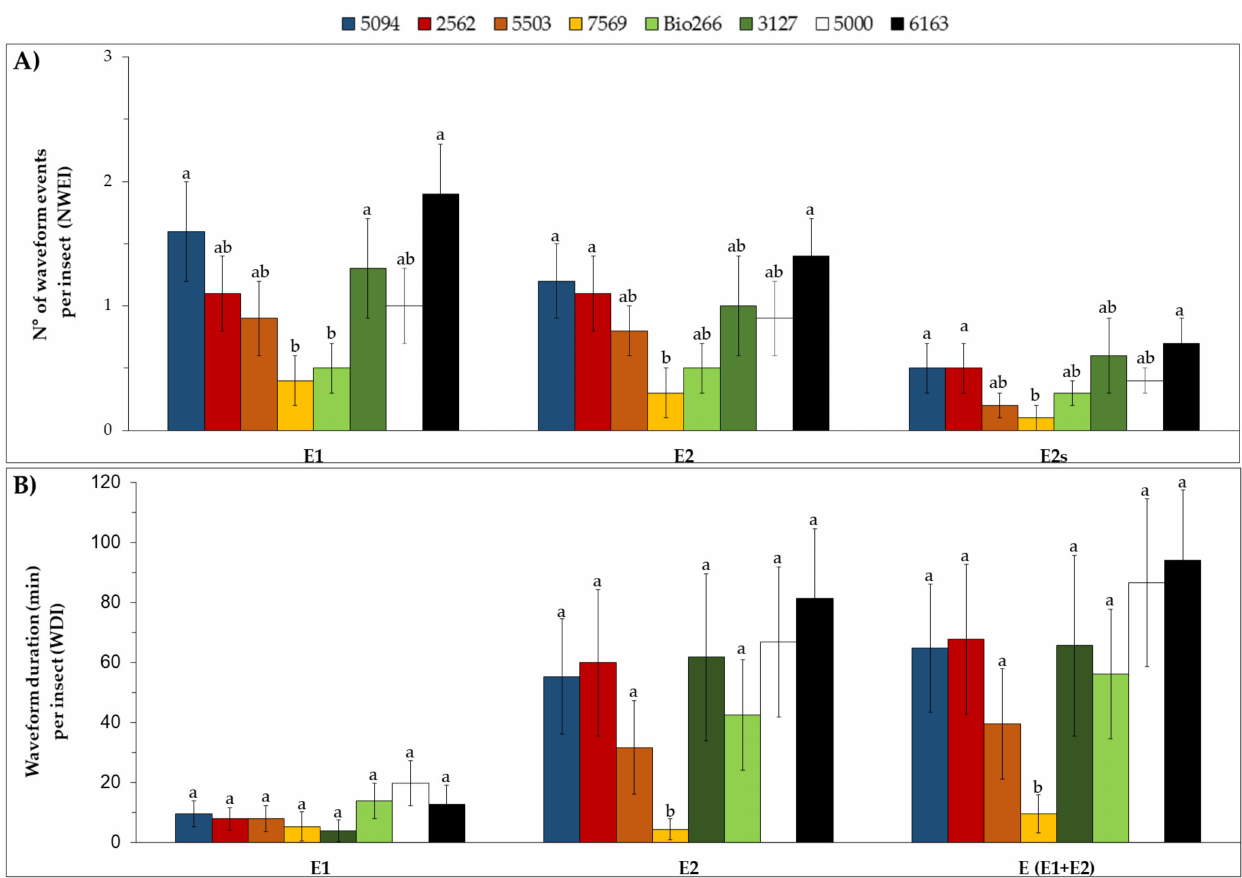
Figure 5. Mean ± SE of the number of waveform event per insect (NWEI) ( A ) and the total waveform duration per insect (WDI) ( B ) of the phloematic parameters of non-viruliferous M. sacchari on ScYLV-infected sugarcane cultivars during 8 h of re-cording. The columns and bars represent the means and the standard error of the mean for each variable, respectively. Statistical comparisons between treatments (in the same EPG parameter) were conducted with a non-parametric Kruskal– Wallis test. Means that share the same letter for each variable are not significantly different ( p > 0.05). Waveform E1: phloem salivation; E2: phloem ingestion; and E2s: sustained phloem ingestion >10